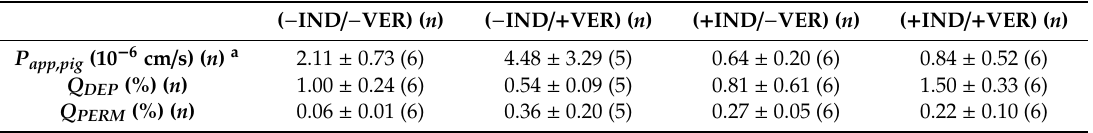
Table 3. P app,pig , Q DEP and Q PERM of fexofenadine without any inhibition ( − IND / − VER), with inhibition of the P-gp transport protein ( − IND /+ VER), with the inhibition of the MRP3 transport protein ( + IND / − VER) and with the inhibition of MRP3 and P-gp transport proteins ( + IND /+ VER), using ex vivo porcine intestine ( n = number of replicates).